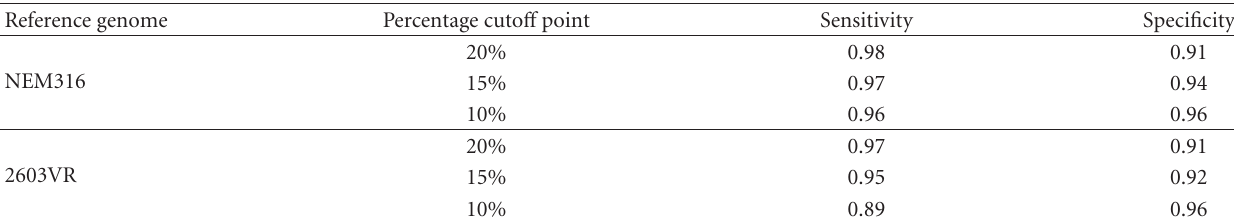
Table 1: Sensitivity (probability open reading frame is detected, given it is truly present) and specificity assessments (probability open reading frame is not detected, given it is not present) of di ff erent cuto ff values in classifying variable open reading frames using fine-tiling oligonucleotide genome arrays created from the genomic sequence of group B Streptococcus strains NEM316 and 2603VR.